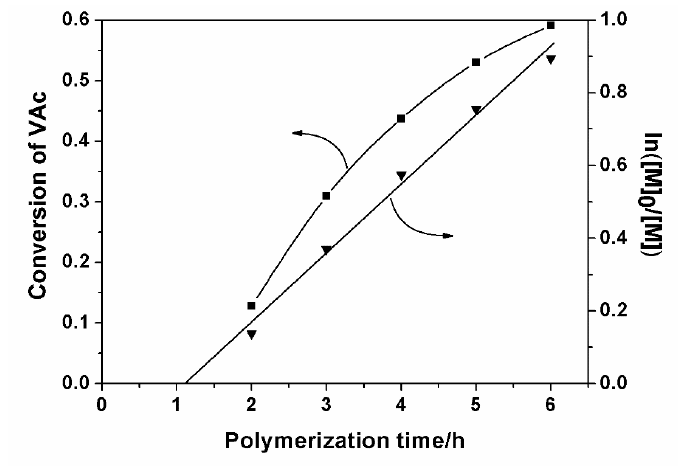
Figure 5. Conversion and ln([M] 0 /[M]) of VAc as a function of polymerization time for the copolymerization of CTFE and VAc.